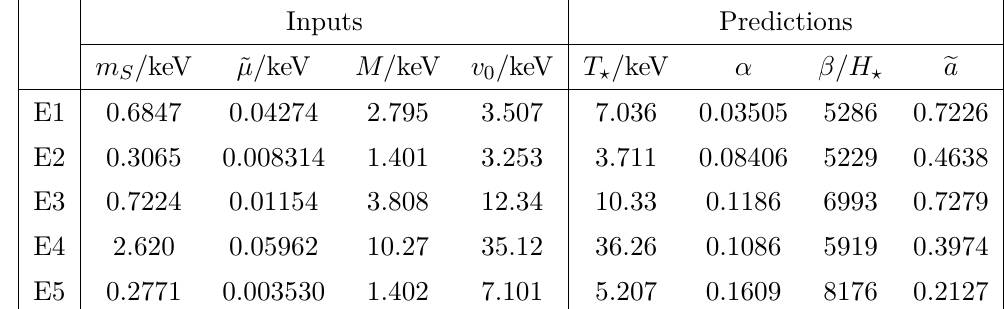
Inputs Predictions m / keV ˜ µ/ keV M/ keV S